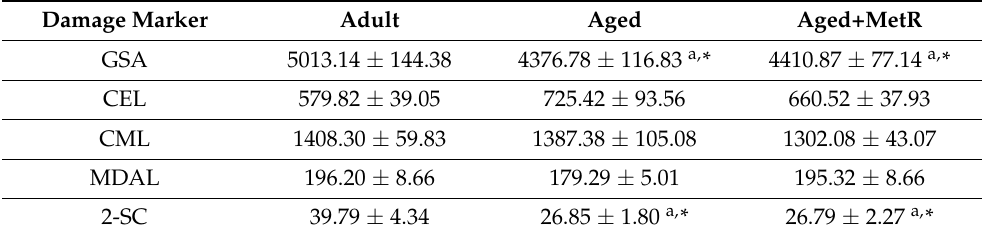
Table 4. Oxidation-derived protein damage markers in the rat cerebellum.